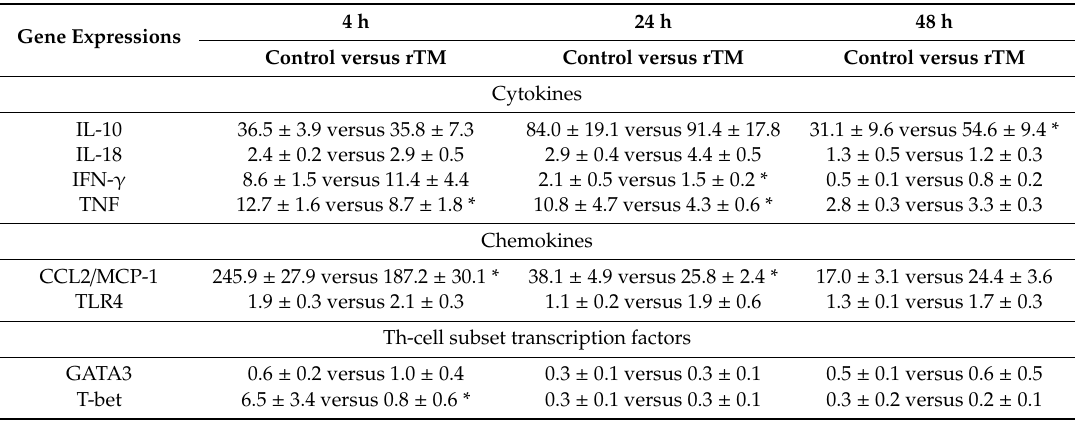
Table 1. E ff ect of recombinant human soluble thrombomodulin (rTM) on gene expression in lipopolysaccharide (LPS)-induced acute kidney